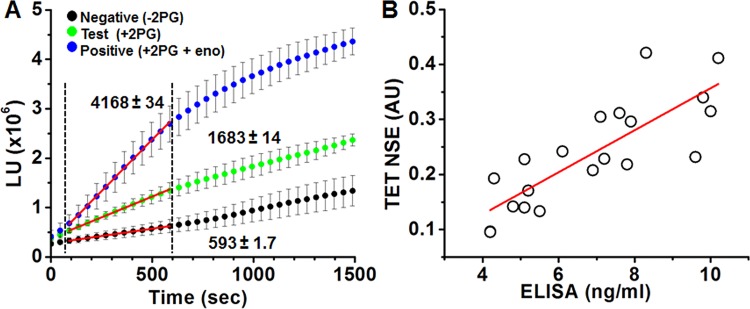
Using the tethered enzyme assay for rapid detection of NSE in human subjects.
A) Representative data as measured from a total of nine wells per subject (triplicate measurements of negative control with no 2PG; the test sample with 2PG; and positive control wells with 2PG and enolase (Eno); mean±STDEV) For calculation of NSE levels, slopes of averaged curves were calculated for the first 0.5–10 minutes of the enzymatic reactions (indicated by the red linear fit in between the dashed lines), then test wells were normalized to positive and negative wells (see methods section). B) High correlation was found between NSE measurements by ELISA (ng/ml) vs. TET assay (AU represents the normalization of test reaction to the negative and positive reactions, as illustrated in A and described in the methods section) as of the human plasma samples. Line indicates best fit. Pearson’s r = 0.815, n = 20.